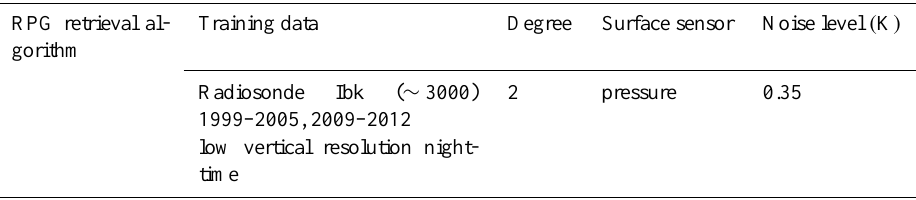
Table 2. Main characteristics of the built-in retrieval (RPG algorithm). “Ibk” stands for the operational radiosonde at the airport of Innsbruck. “Degree” refers to the order of the employed regression (see Eq. 2).